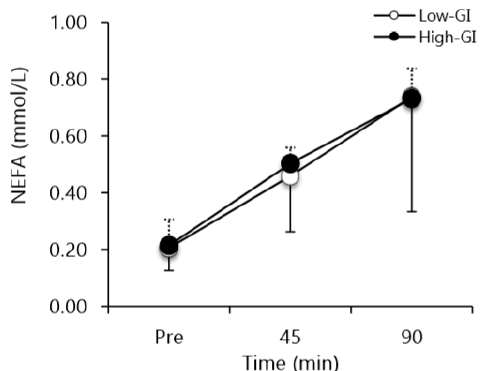
Figure 4. Non-esterified fatty acid concentrations before, at half time, and at the end of the simulated soccer match for low- and high-GI conditions. Values are means ± standard deviation (SD). Time main effect ( p < 0.05) with 90 min >45 min >pre ( p < 0.05). “Pre” denotes venous blood draw prior to the simulated soccer match.